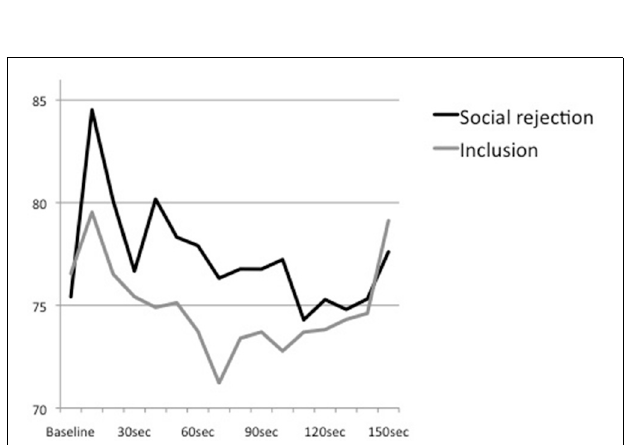
during/after the Cyberball game and during/after the waiting period). (C) Means of positive affect ratings (at baseline, during/after the Cyberball game and during/after the waiting period). (D) Means of negative affect ratings (at baseline, during/after the Cyberball game and during/after the waiting period).